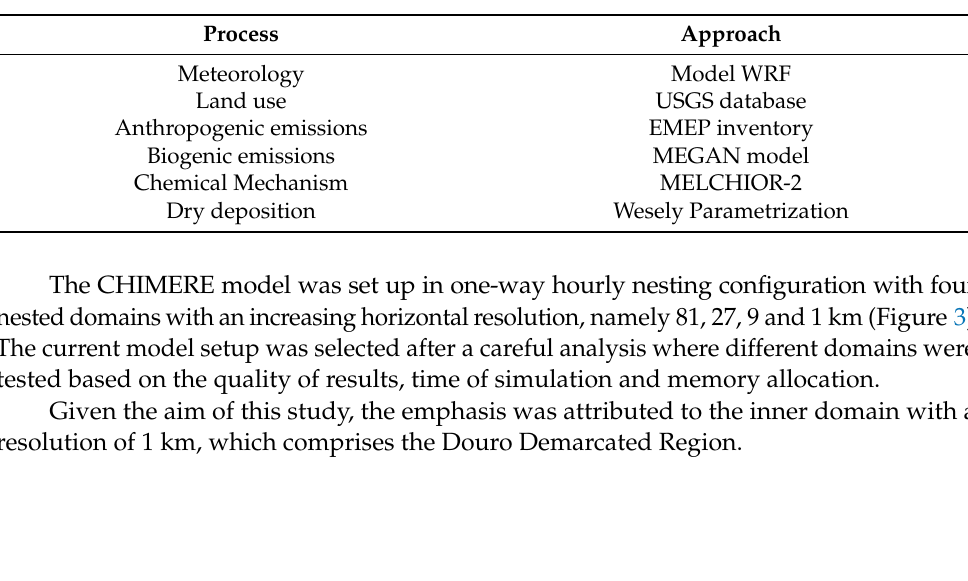
Table 1. Summary of main CHIMERE model options and methodology